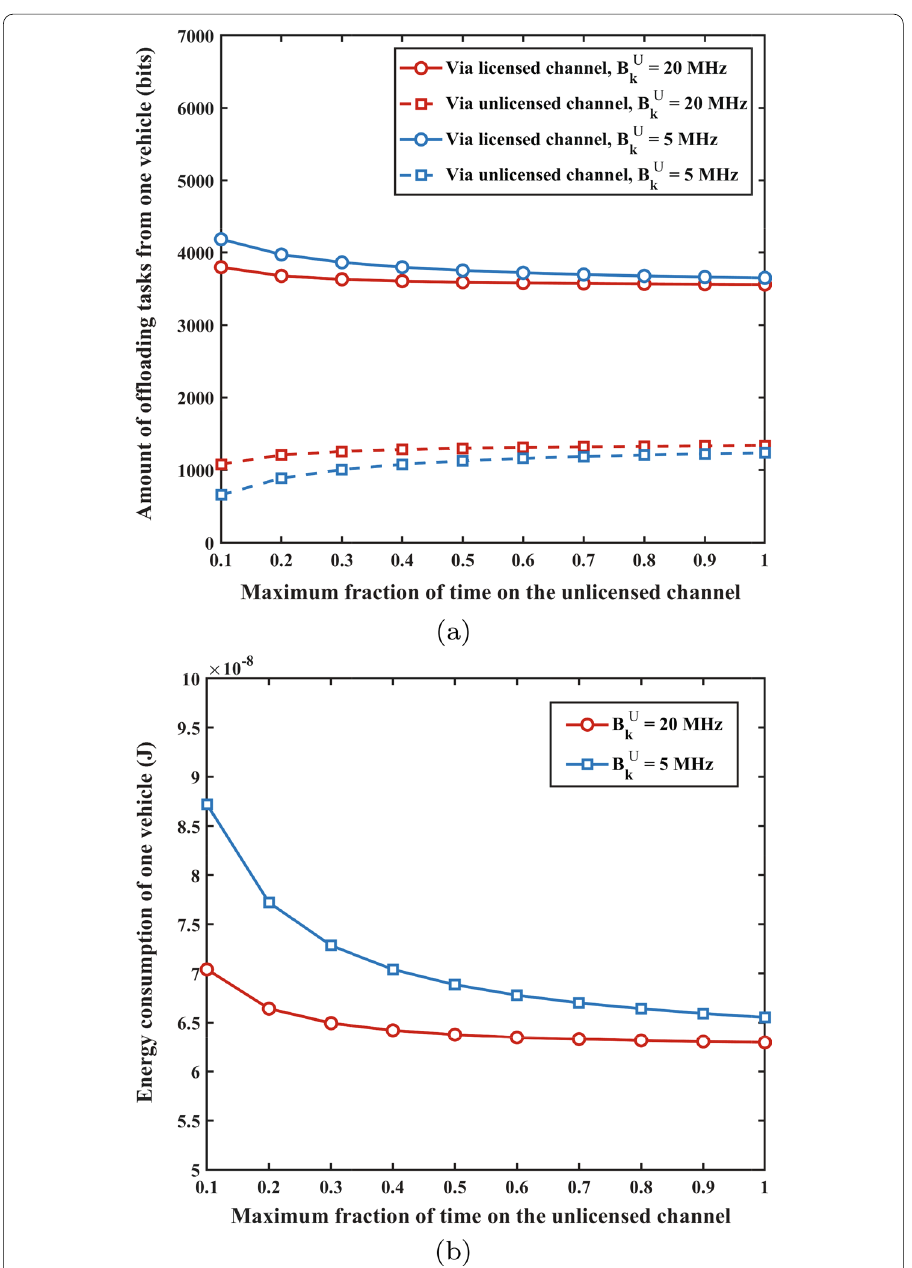
Fig. 5 The effect of available time fraction on unlicensed channels on the task offloading and energy consumption at the vehicle, K 40, B L 20 MHz: a the impact on task offloading from one vehicle; b the = = impact on energy consumption of one